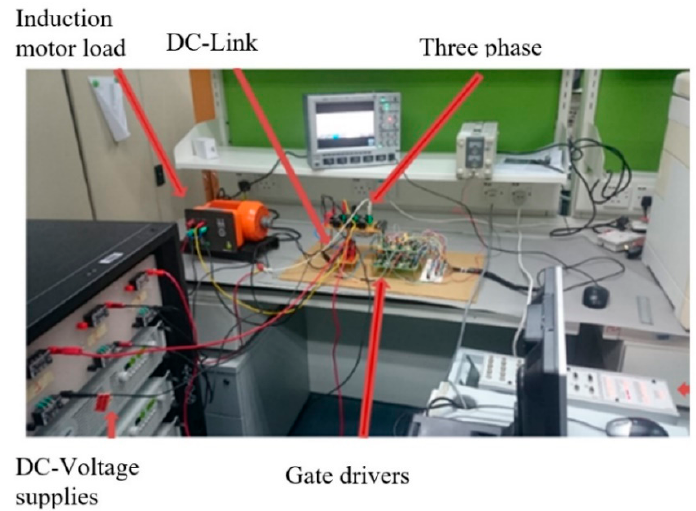
Table 8. N -level T-Type inverter component rating.